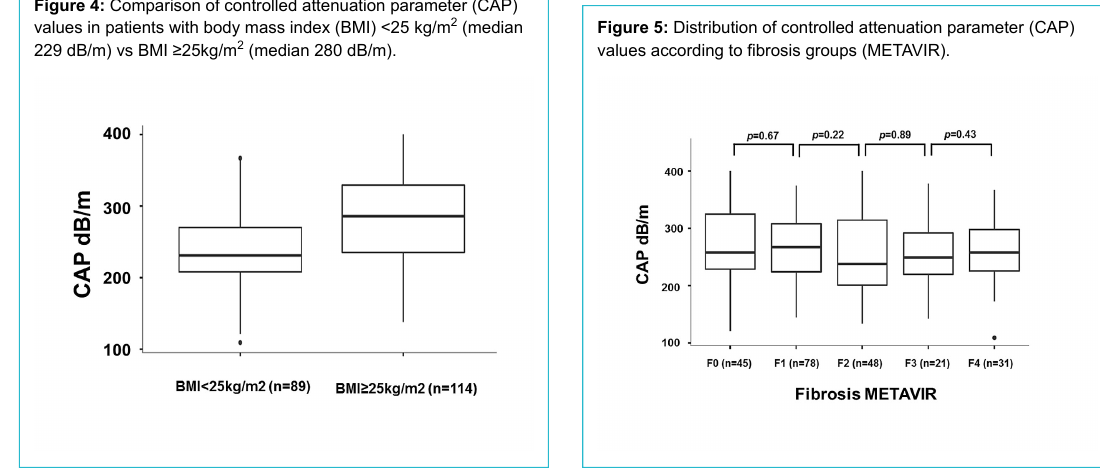
Figure 5: Distribution of controlled attenuation parameter (CAP) values according to fibrosis groups